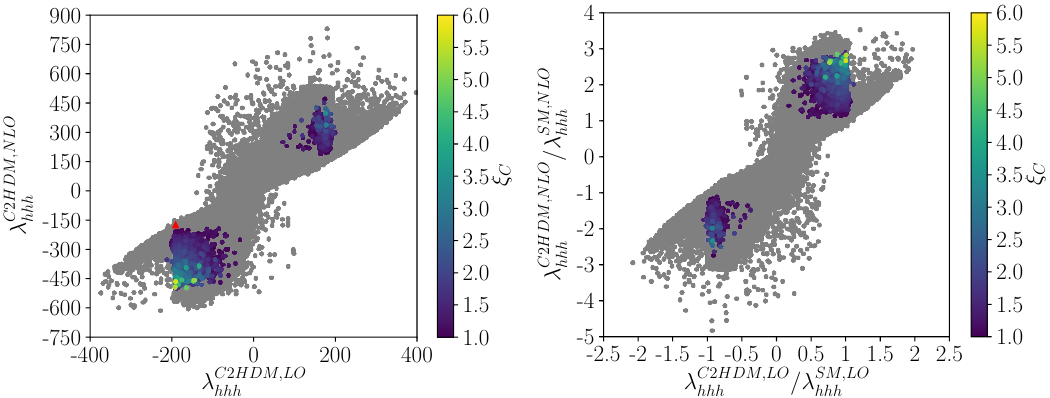
Figure 9 . Type I, H 1 = h : left: the NLO C2HDM trilinear Higgs self-coupling between three SM-like Higgs bosons versus the LO value. The red triangle marks the SM point. Right: the ratio of the C2HDM trilinear Higgs self-coupling between three SM-like Higgs bosons and the SM counterpart at NLO versus the LO ratio. Grey: all points passing the constraints; colour: points with additionally (cid:24) c 1. Both plots: all 2HDM (cid:21)